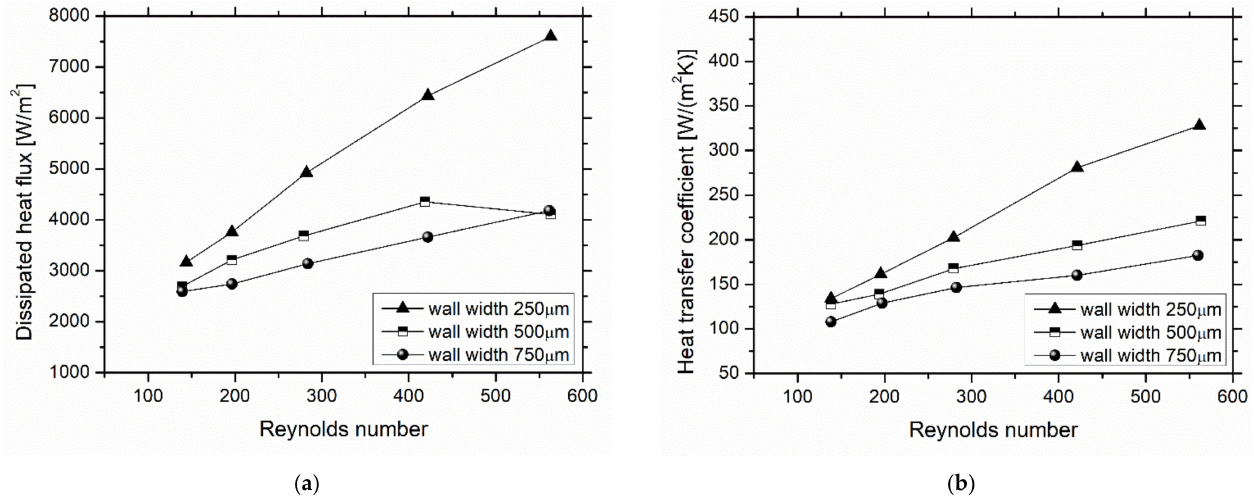
Figure 4. Effect of the wall width on: ( a ) dissipated heat flux and ( b ) heat transfer coefficient for single-phase water flow in the heat